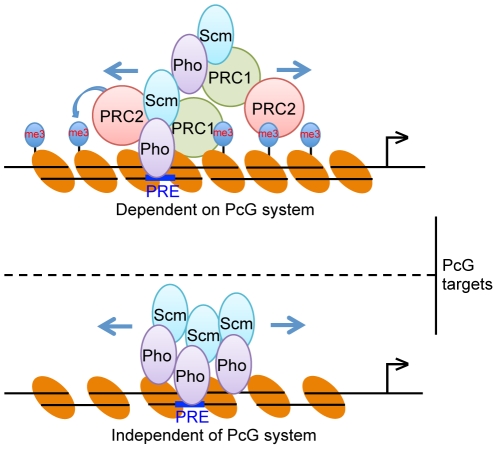
Proposed models for the regulation of PcG target gene expression-mediated by BmPho and BmScm.In this study, we envision that BmPho and BmScm regulate two classes of PcG targets. One class is based on the classic PcG system (Top), and the other one is attributed to the complex itself (Bottom). In the top panel, the DNA-binding protein BmPho associated with BmScm recognizes Polycomb response elements (PRE) and recruits other PRC2 and PRC1 complexes. PRC2 catalyzes the H3K27me3 mark and spreads out bilaterally, finally, resulting in a condensed chromatic status. In the bottom panel, the complex of BmPho and BmScm binds to PRE in the target gene, and subsequently forms the repeated units probably through homodimer and/or heterodimer themselves. Further details are shown in the text.